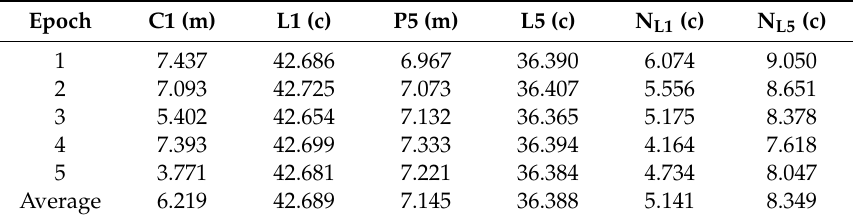
of Table 2 for the function Ψ ( N L 1 )